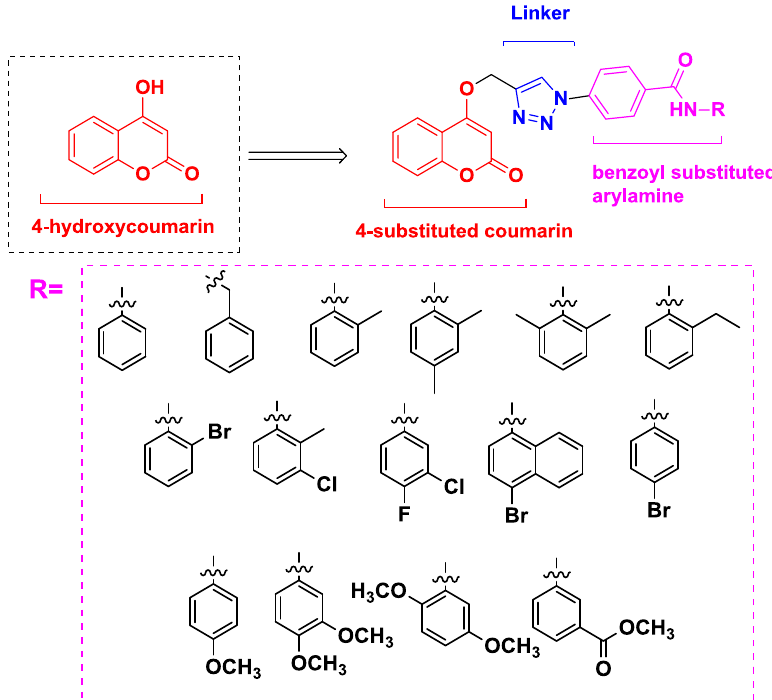
Figure 3. Rationale design of the title compounds.